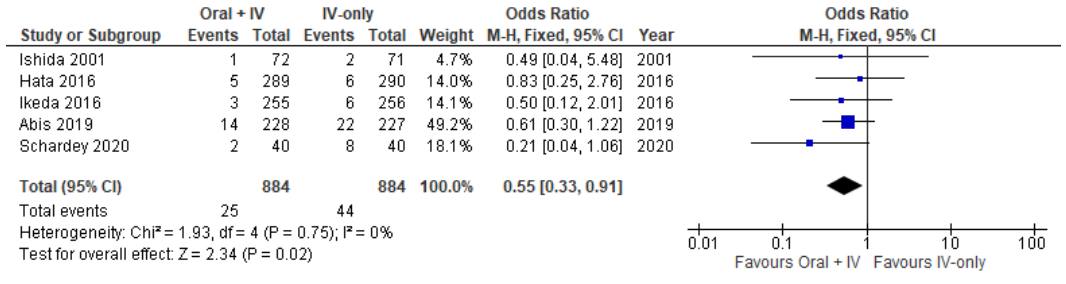
Figure 5. Forest plot of anastomotic leakage comparing oral + IV group and IV-only group.